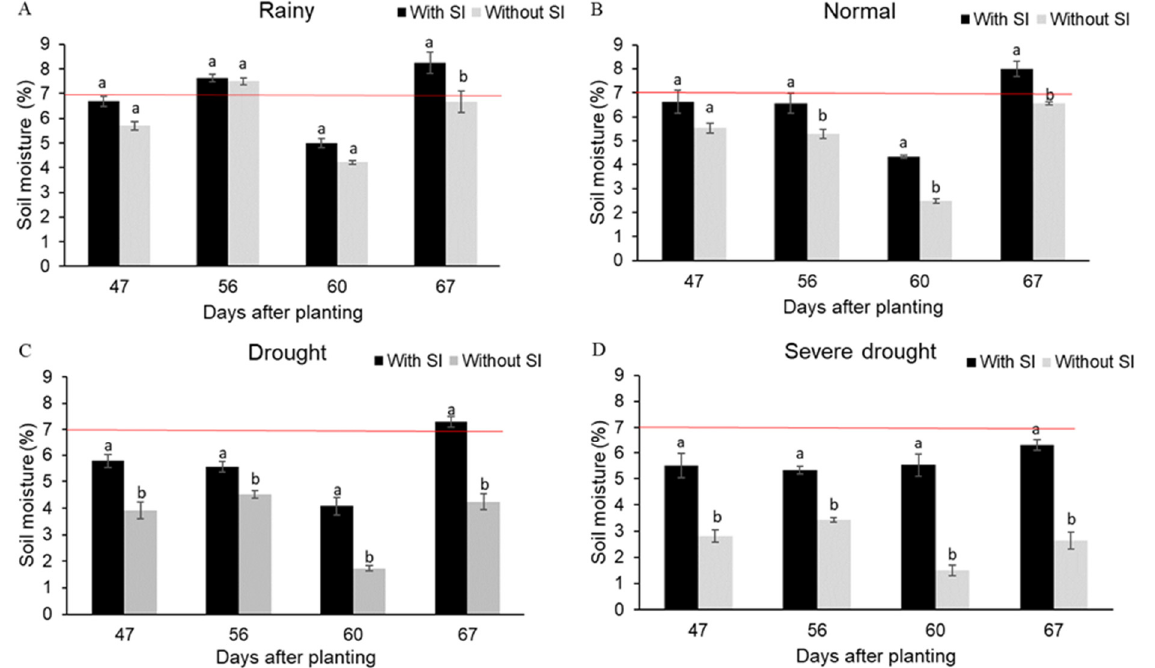
Figure 2. Soil moisture (layer from 0 to 20 cm) in areas cultivated with maize for the Rainy ( A ), Normal ( B ), Drought ( C ) and Severe drought ( D ) scenarios, showing sampling date and presence or absence of supplemental irrigation (SI) with brackish water (ECw = 4.5 dS m − 1 ). For each sampling date, means followed by the same letters do not differ ( p ≥ 0.05) from each other according to the Tukey test. Error bars represent the standard error of the mean ( n = 4). The red line in each figure represents the field capacity of the soil.